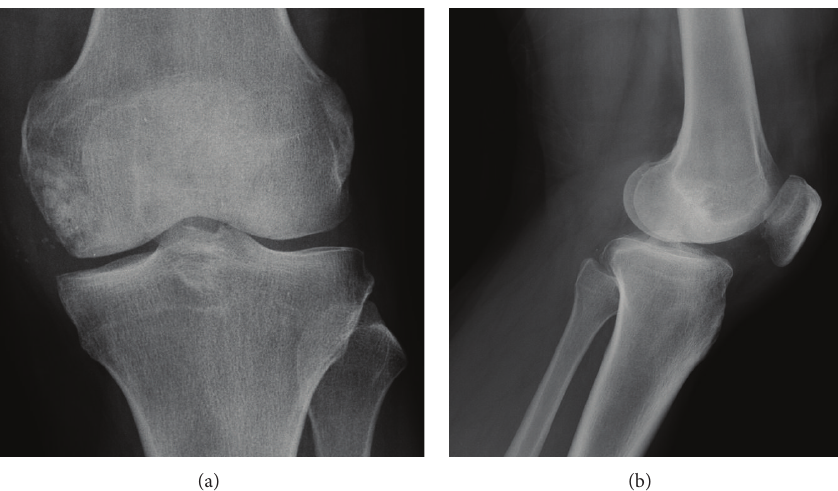
Figure 3: X-rays in AP (a) and profile (b) showing iliac bone graft placed in the site of the removal of the foreign body in the medial femoral